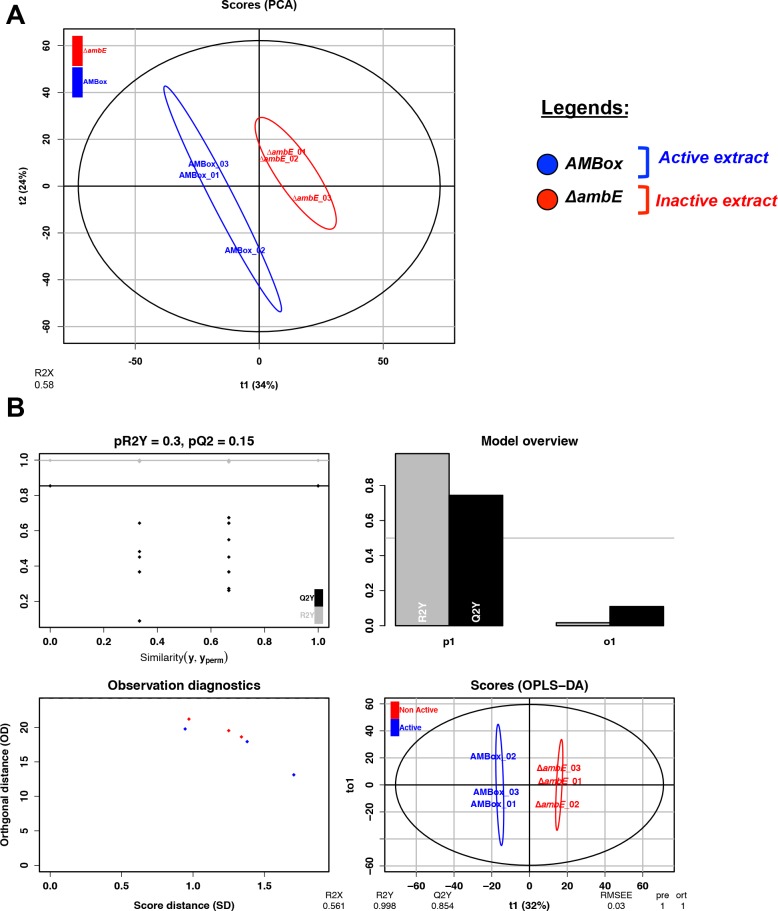
Unsupervised and OPLS-DA results from metabolomic analysis 2.(A) PCA analysis using HRMS2 data from three different extracts: PAO1, AMBox and ΔambE (three replicates). (B) Scores and model overview of the OPLS-DA realized between strains releasing a GRA (AMBox), classed as ‘Active’ (blue color) or not releasing a GRA (∆ambE), classed as ‘Not Active’ (red color). All features are reported in Supplementary file 3, sheet ‘MS-MS analysis 2’.